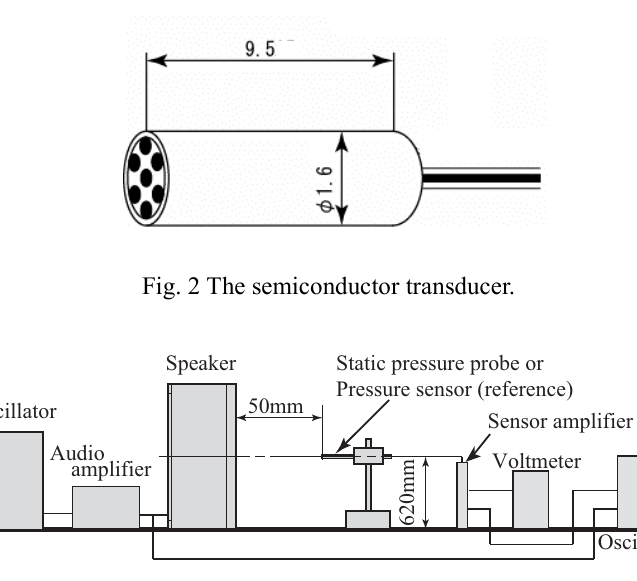
Fig. 3 Experimental set up for the examination of the characteristics of frequency